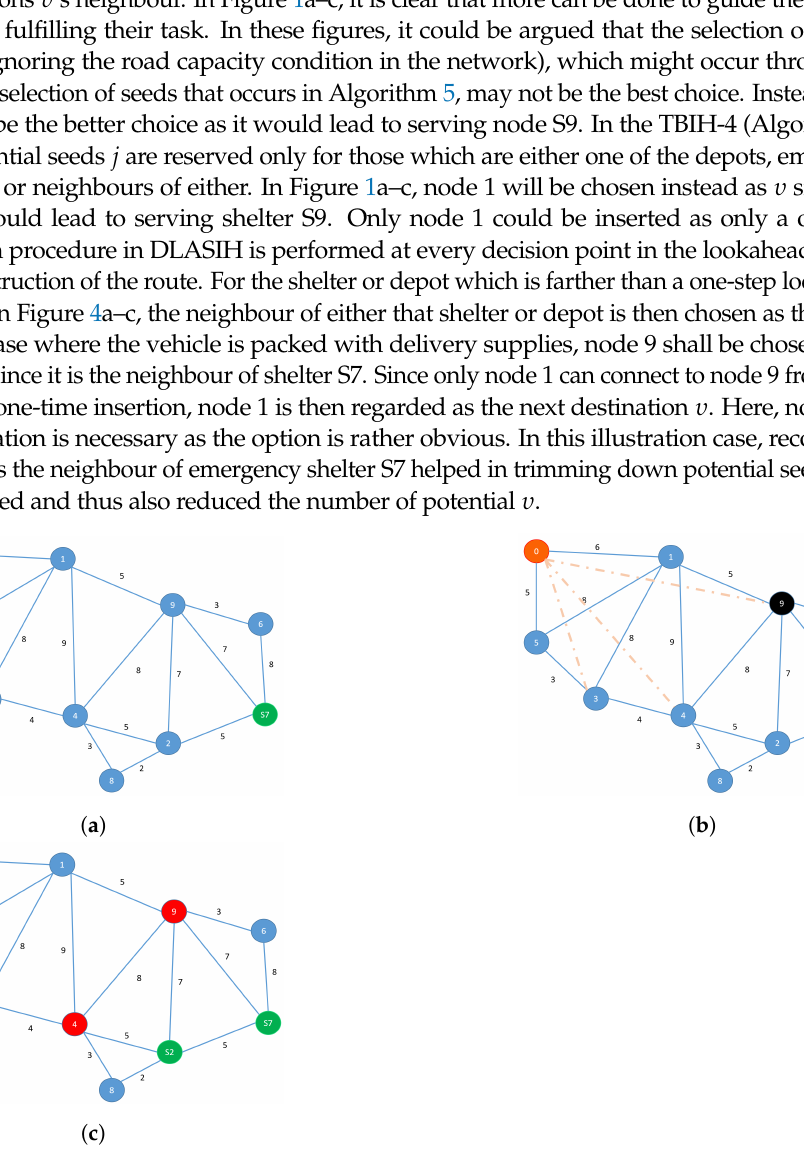
Figure 4. Performing the DLASIH in the TBIH-4 in an example network ( a ) with node 0 as current position of vehicle m ready to serve and node S7 as an emergency shelter. The potential seeds j are considered in ( b ) and Node 9 was selected since it is the neighbour of shelter S7 in ( c ). As a result, node 1 ( υ ) is inserted and route (0–1–9–S7) is constructed. ( c ) shows two potential seeds j (node 4 and node 9) in which case a random selection between node 4 and node 9 as a seed is